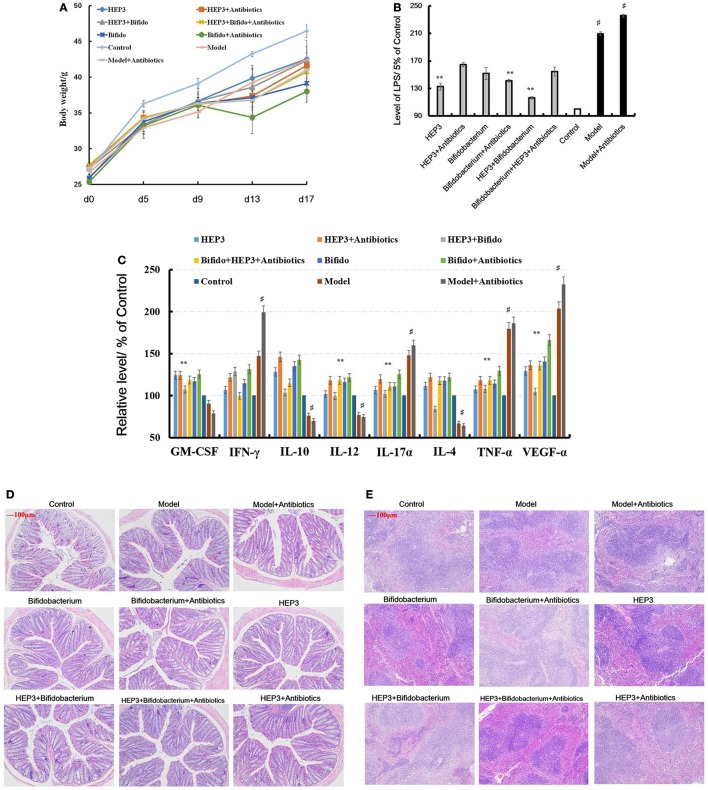
HEP3 extracted from Hericium erinaceus improved the pathological parameters of the trinitrobenzenesulfonic acid solution (TNBS)-induced mice. (A) The body weight changes; (B) the levels of lipopolysaccharide in serum; (C) the levels of cytokines GM-CSF, tumor necrosis factor (TNF)-γ, 1L-10, interleukin (IL)-12, 1L-17α, 1L-4, TNF-α, and vascular endothelial growth factor in serum; (D) the histopathological changes in colon; and (E) the histopathological changes in spleen. Control is the normal group; model is the TNBS-induced group; model and high-dose antibiotics; HEP3 [100 mg/(kg ⋅ day)], Bifidobacterium, HEP3 and high-dose antibiotics, HEP3 and Bifidobacterium, Bifidobacterium and high-dose antibiotics, HEP3 and Bifidobacterium and high-dose antibiotics.